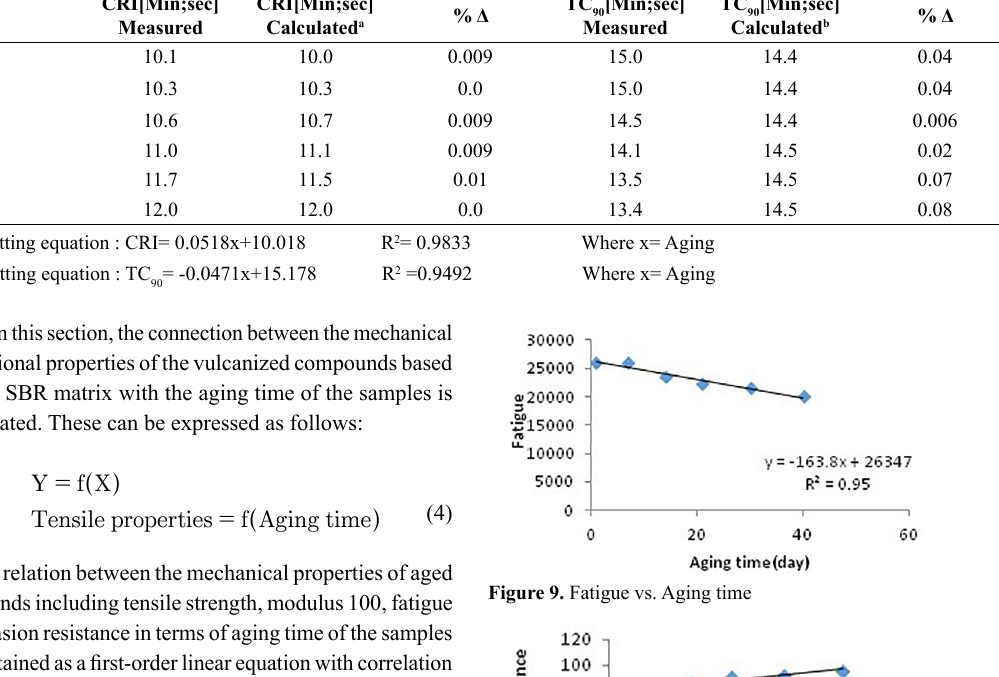
Table 7. Experimental and calculated rheological properties of composites based on BR / SBR blends. Aging